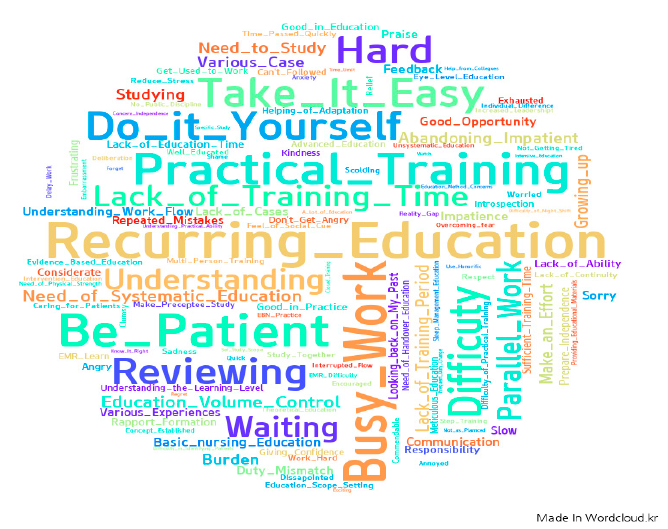
Figure 2. Feelings and thoughts regarding preceptorship, as shown in the reflective journals.